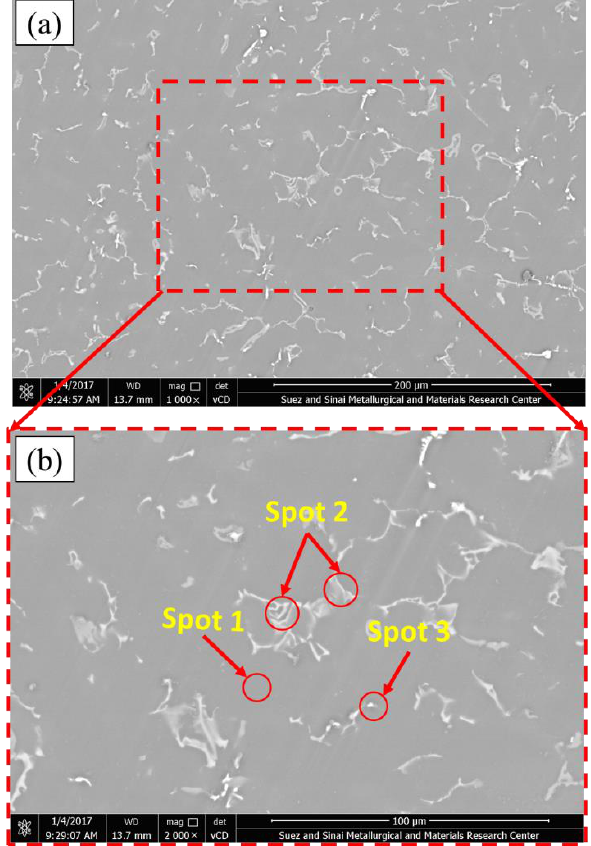
Figure 4. ( a ) Low and ( b ) high magnification SEM images of the as-cast AZ91 microstructure.